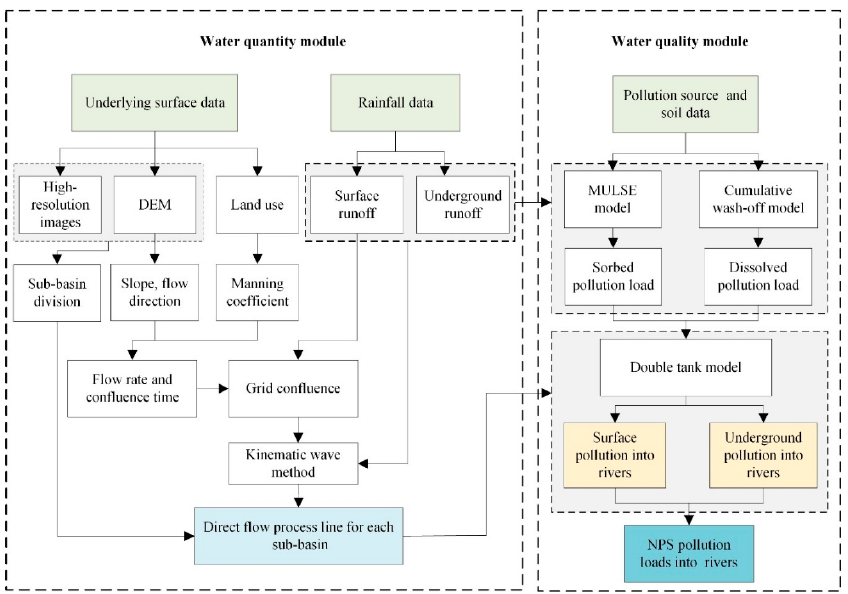
Figure 4. Algorithm employed to simulate NPS pollutants .